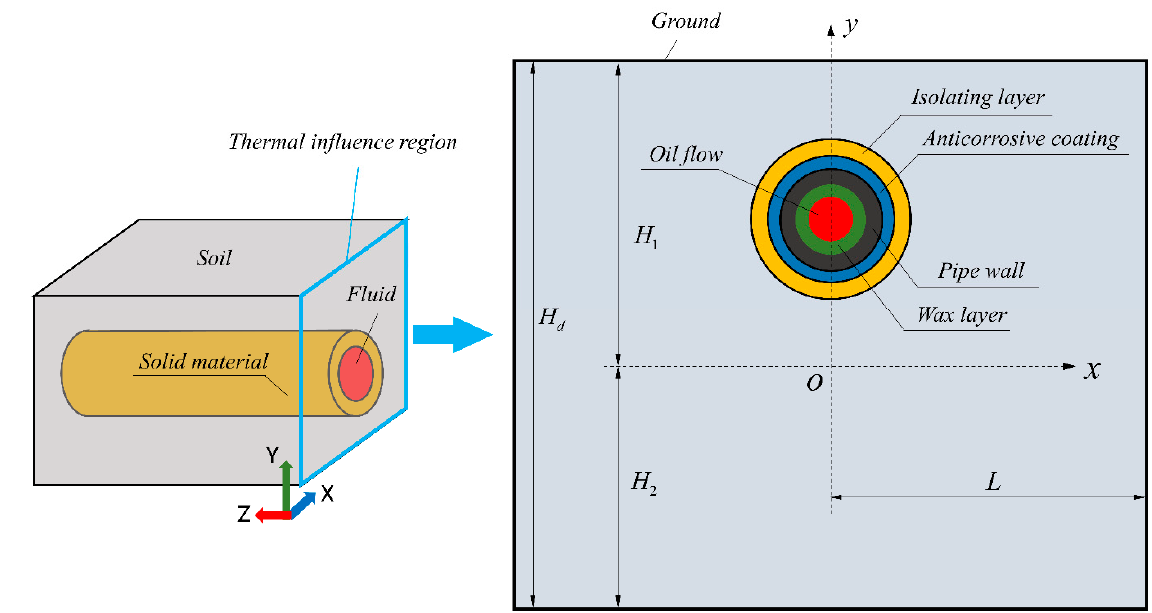
Figure 1. The geometry of buried oil pipeline system.